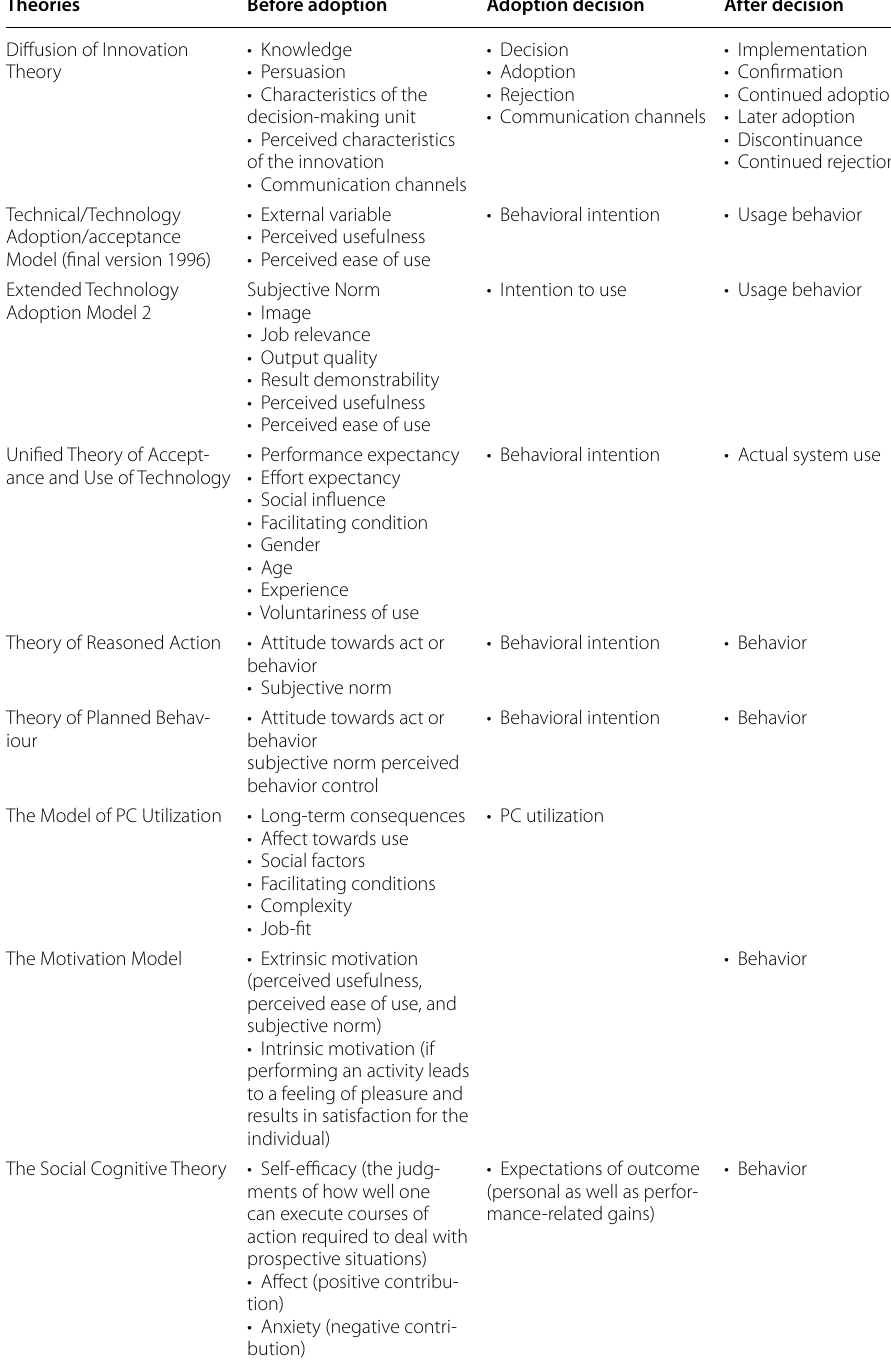
Table 11 Constructs applied in the technology adoption theories and technology adoption decision